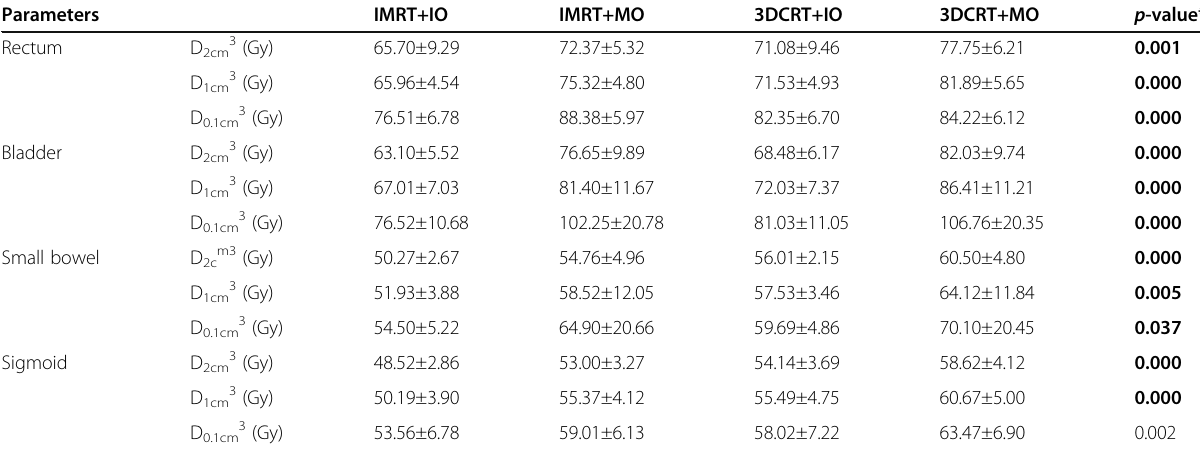
Table 2 The total EQD 2 of organ at risks for different treatment technique